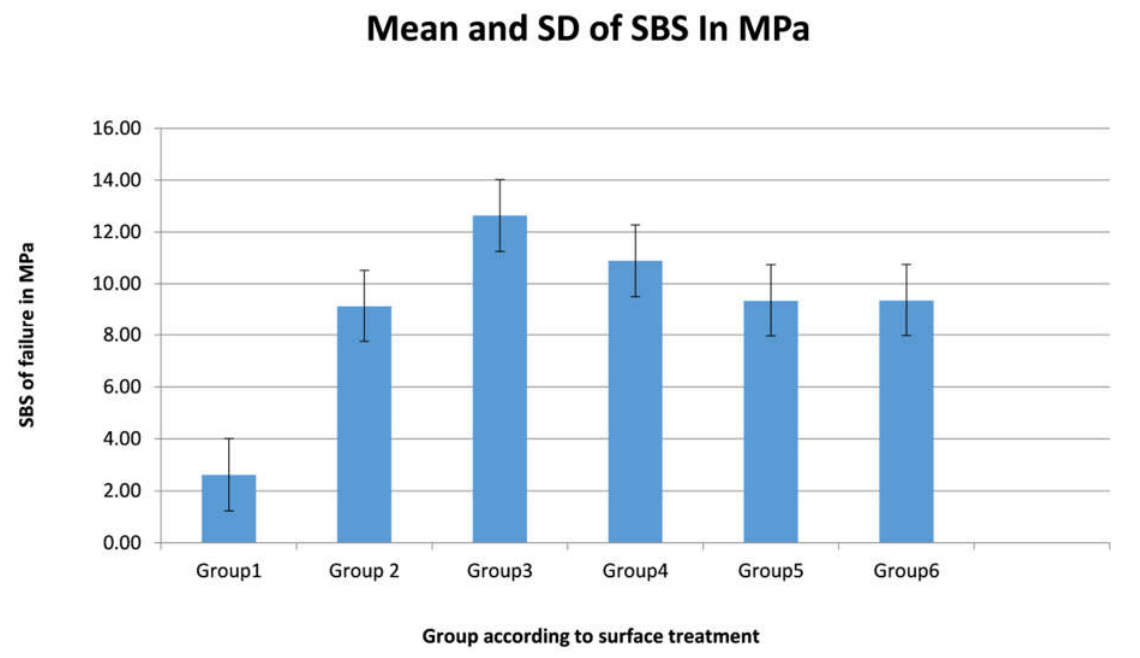
Figure 3. The mean values and SD of the shear bond strength for each group.